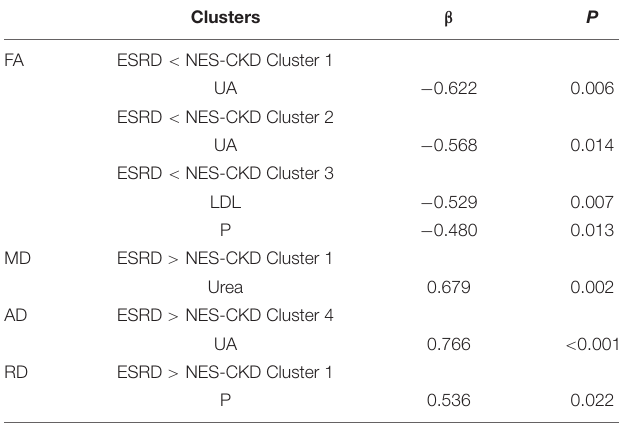
TABLE 4 | Multiple linear regression analysis.